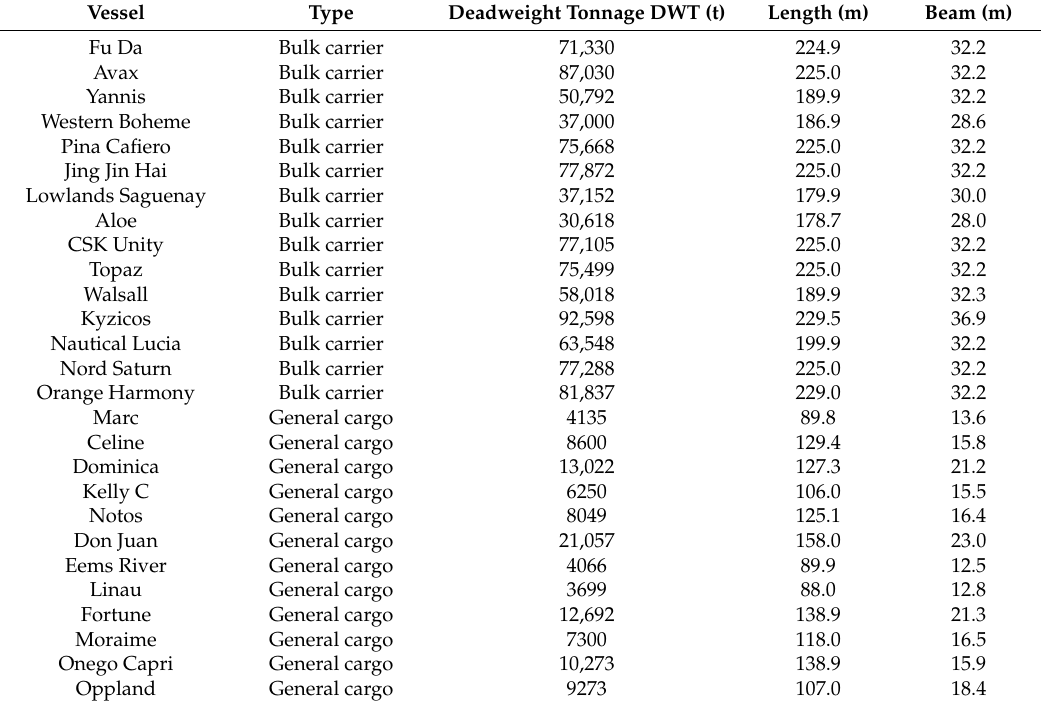
Table 1. Characteristics of the vessels measured during the field campaign.